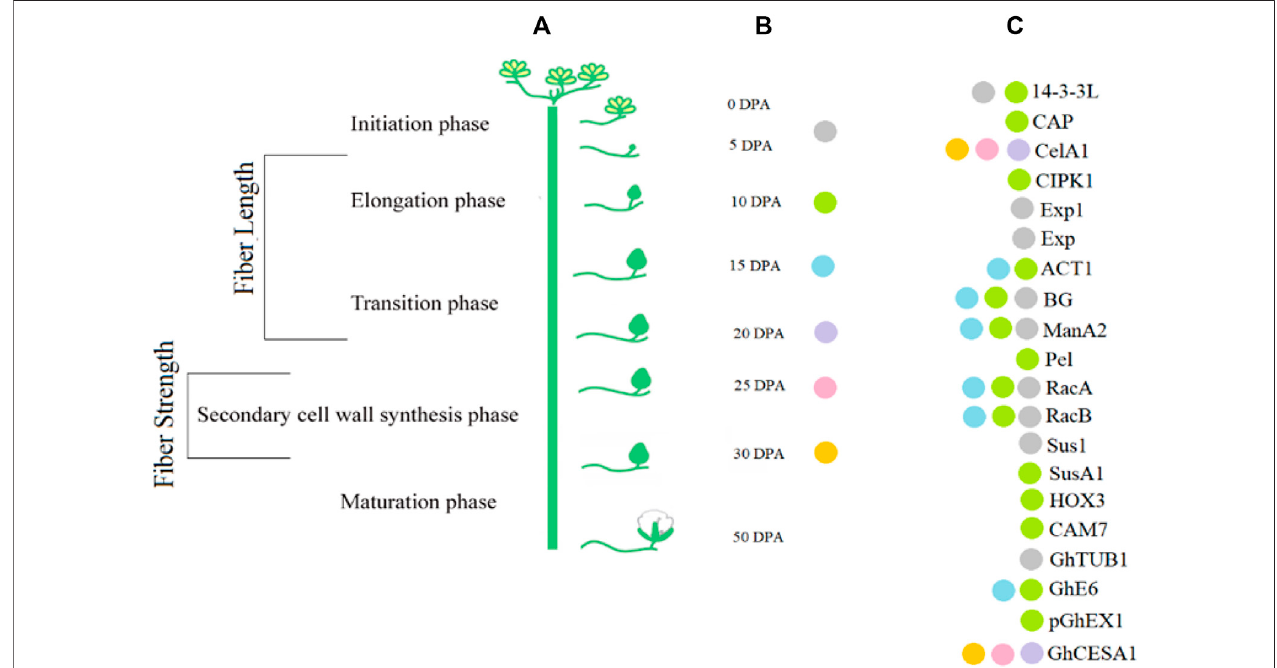
FIGURE 3 | Interaction of candidate genes involved in regulation of fi ber quality